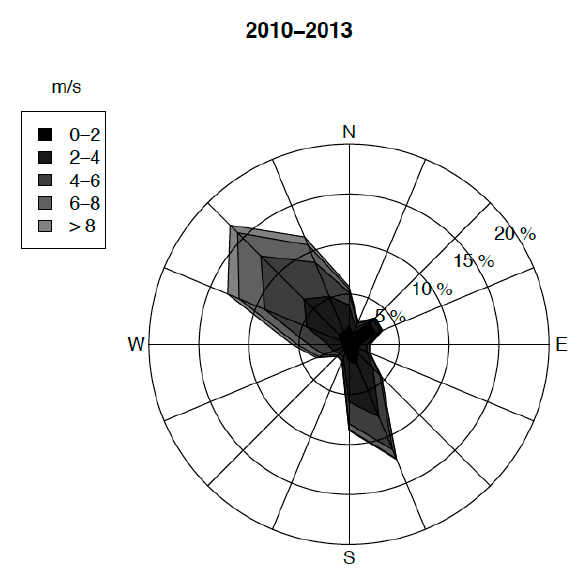
Figure 3. Distribution of the wind directions throughout the four years experiment. The wind rose indicates the occurrence of wind speeds for 16 wind